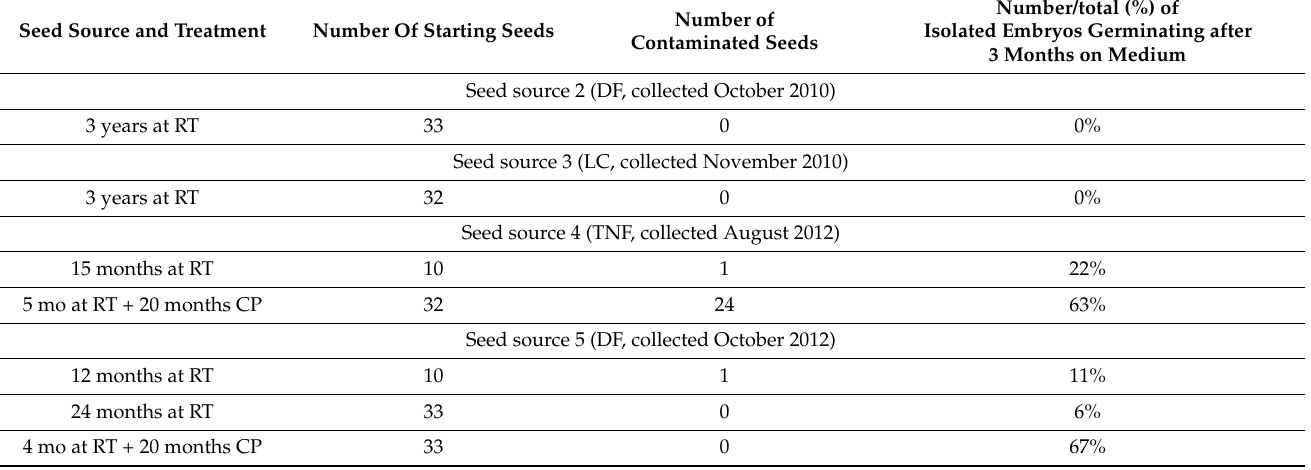
Table 8. Xerophyllum asphodeloides isolated embryo germination in vitro after long term seed storage at room temperature or storage at room temperature followed by cryopreservation.